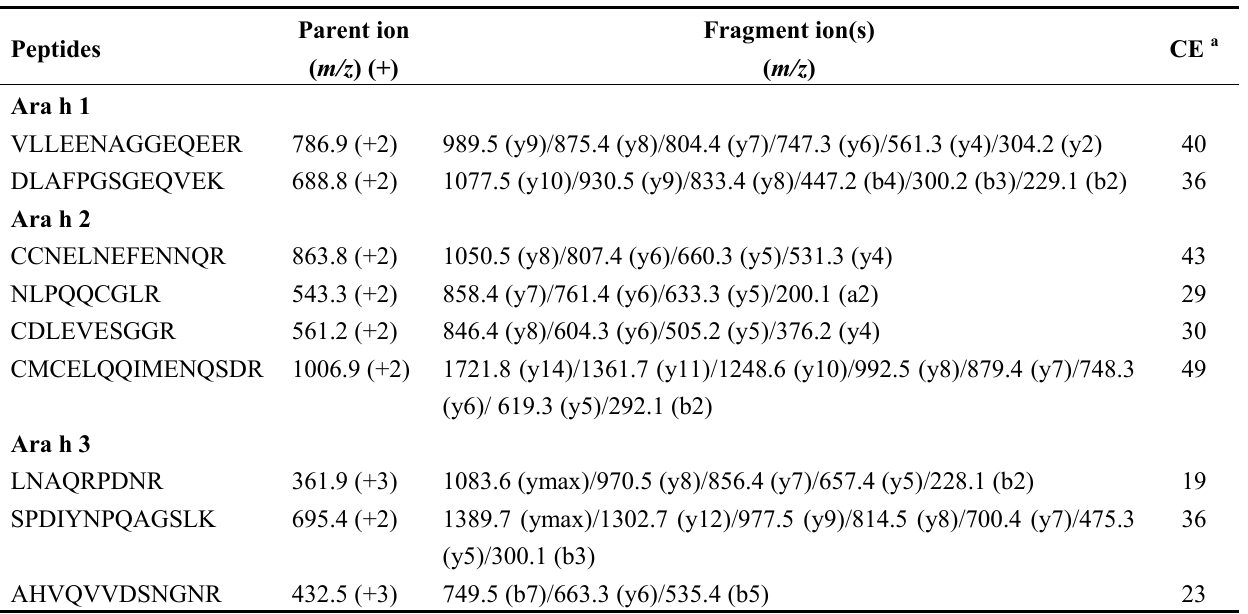
Table 2. Selective Reaction Monitoring (SRM) transitions monitored for detection of Ara h 1, Ara h 2 and Ara h